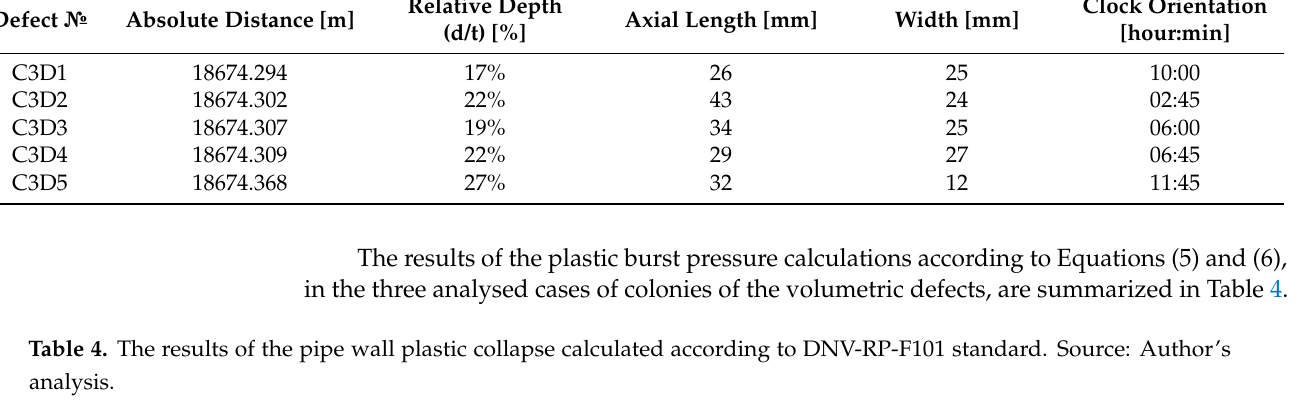
Table 3. Flaws dimensions in the colony 3. Source: Author’s analysis. Defect №